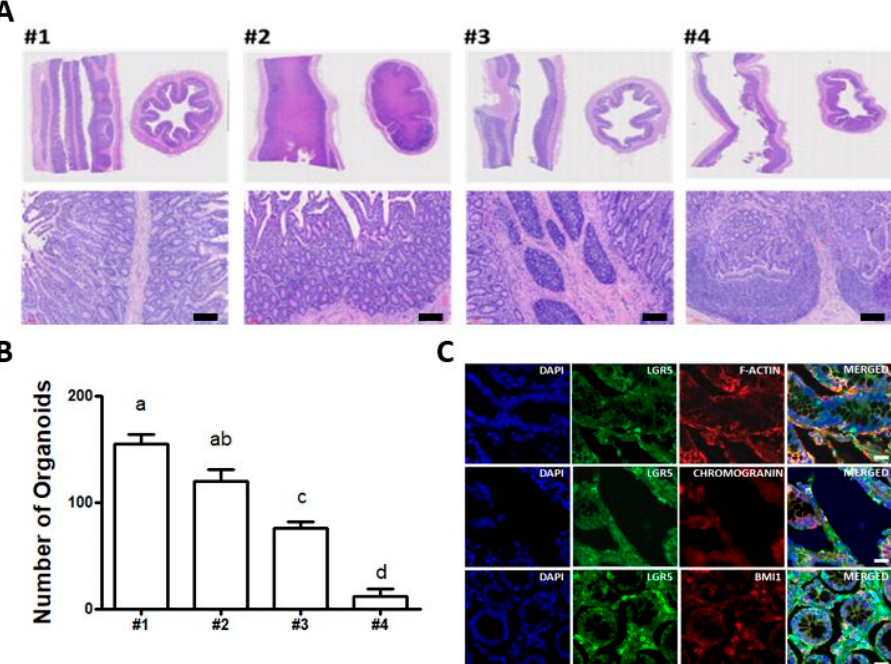
Figure 2. Immunohistochemical analysis of bovine small intestine: ( A ) haematoxylin and eosin histological staining to identify distinct crypt and villus structures from four different locations (#1, #2, #3, and #4) in the jejunum between the duodenum and ileum. Scale bar: 300 μ m; ( B ) the number of intestinal organoids per basement matrix dome to verify the efficiency of the derivation of intestinal organoids from four different locations. The number of intestinal organoids derived from location #1 in the jejunum close to the duodenum was significantly higher, compared to locations #3 and #4. The values are the means plus the standard error of mean (S.E.M) and different letters (a–d) indicate significant differences ( p < 0.05); ( C ) immunohistochemistry of LGR5, Bmi1, F-actin, and Chromogranin A in bovine small intestine. The fluorescently stained crypts were counterstained with diamidino-2-phenylindole (DAPI). Scale bar: 20 μ m.